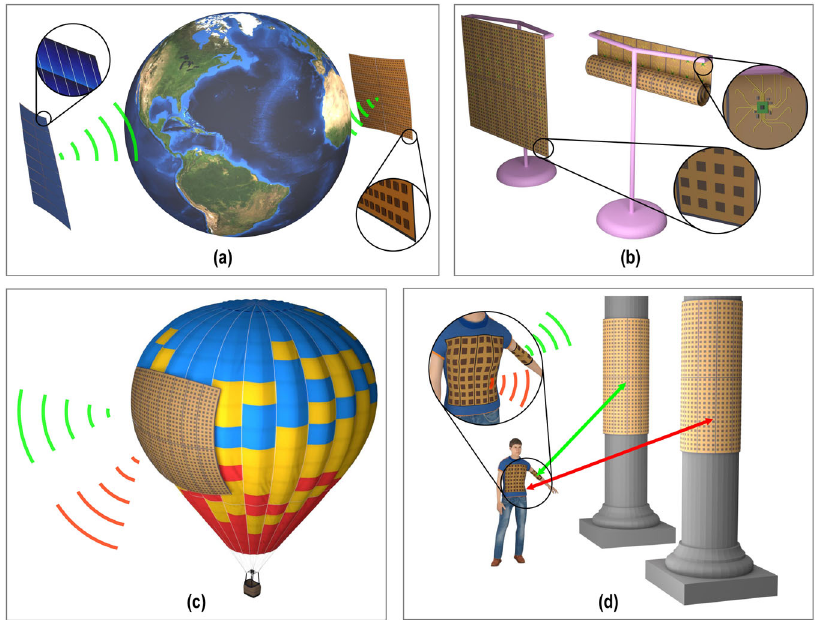
Fig. 1 Example applications that are enabled by fl exible smart antennas. a Lightweight deployable space structures. b Ad-hoc deployable antenna arrays. c Dynamic conformal surfaces. d Wearable conformal